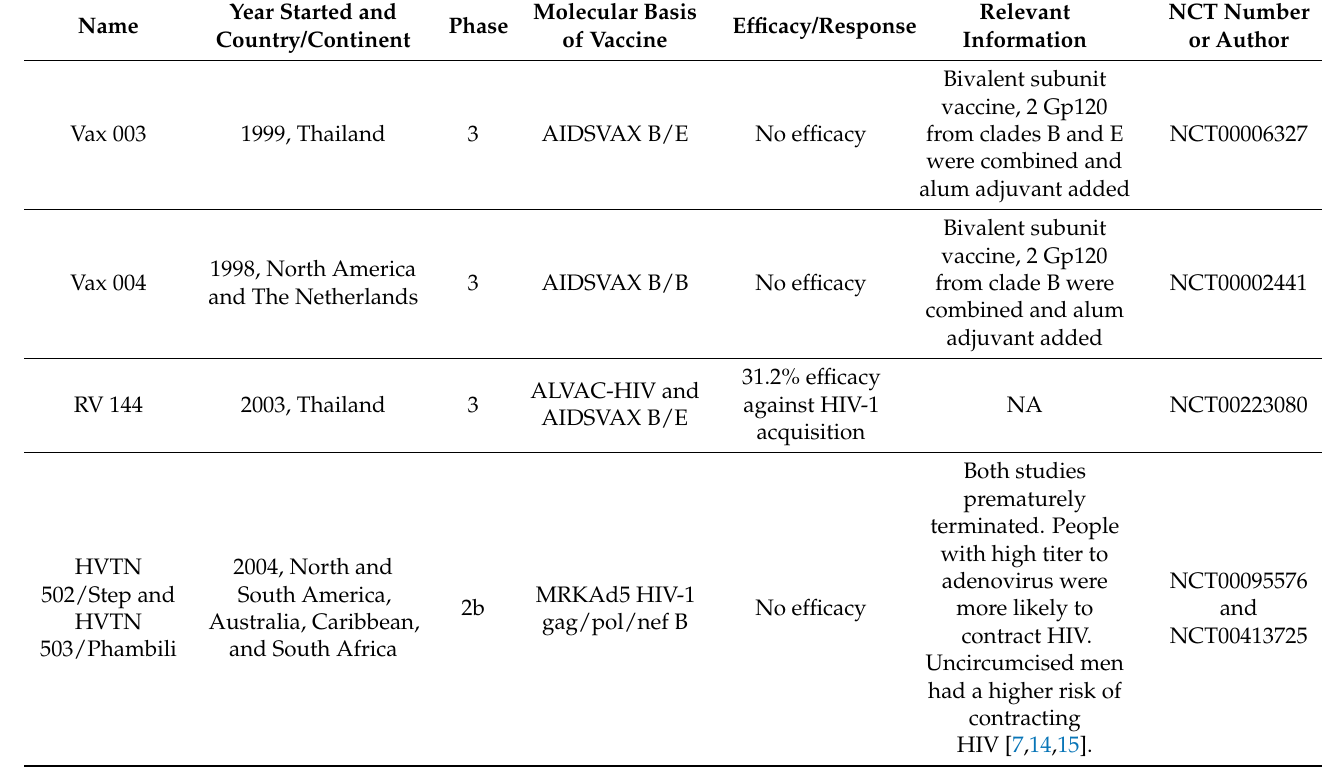
Table 1. Historic phase 2b and 3 HIV-1 vaccine clinical